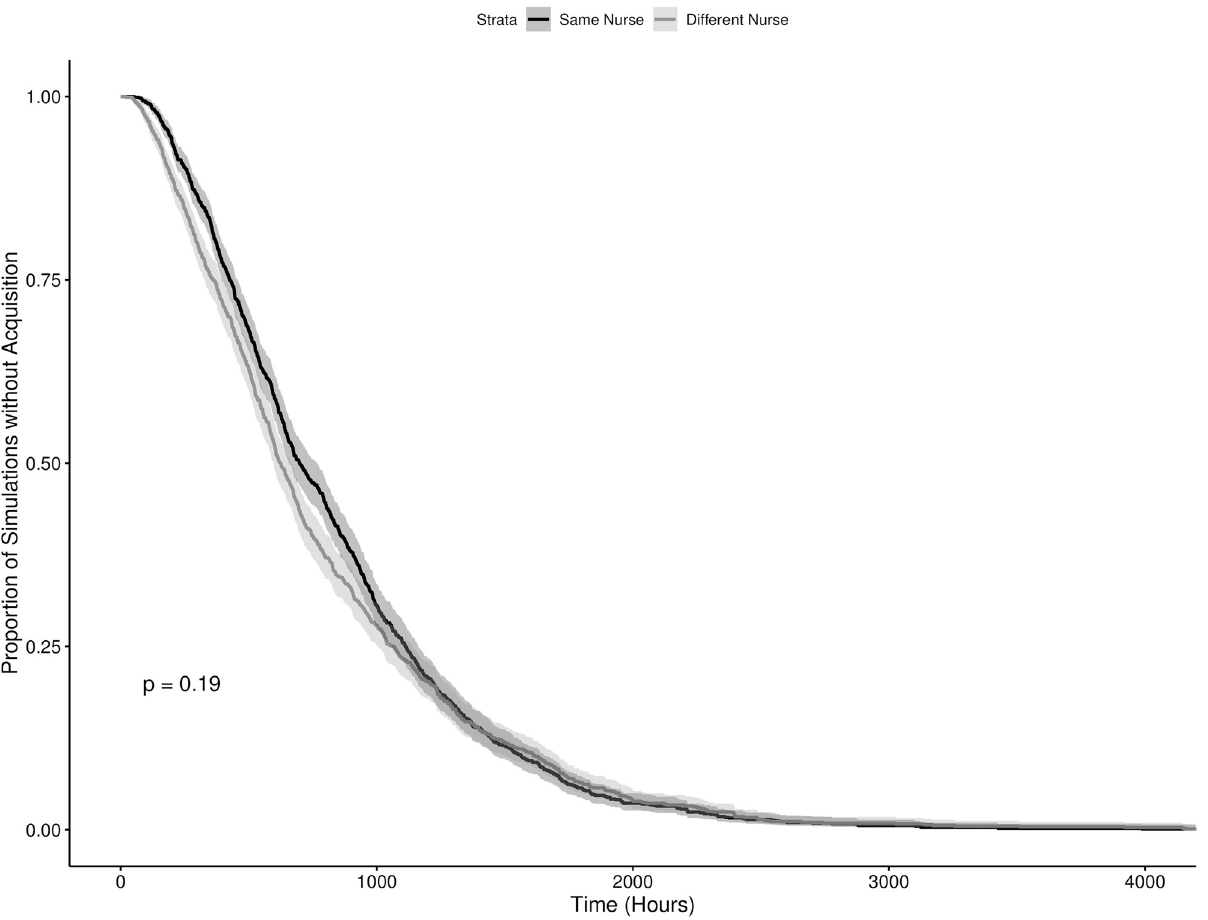
Fig 4. Time to third MRSA acquisition in an ICU meta-population model with potentially colonized admissions. The dark and light grey lines indicate starting conditions where two initially colonized patients are cared for by the same and different nurses respectively, with the shaded regions representing the corresponding 95% confidence